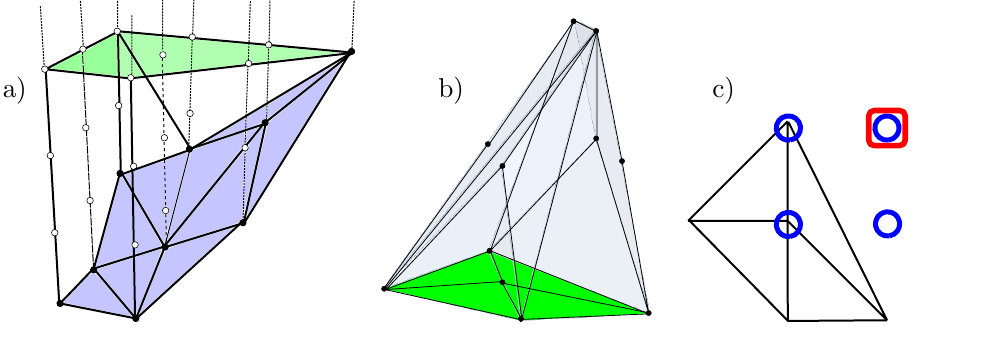
(cid:3) at generic height (shaded 3